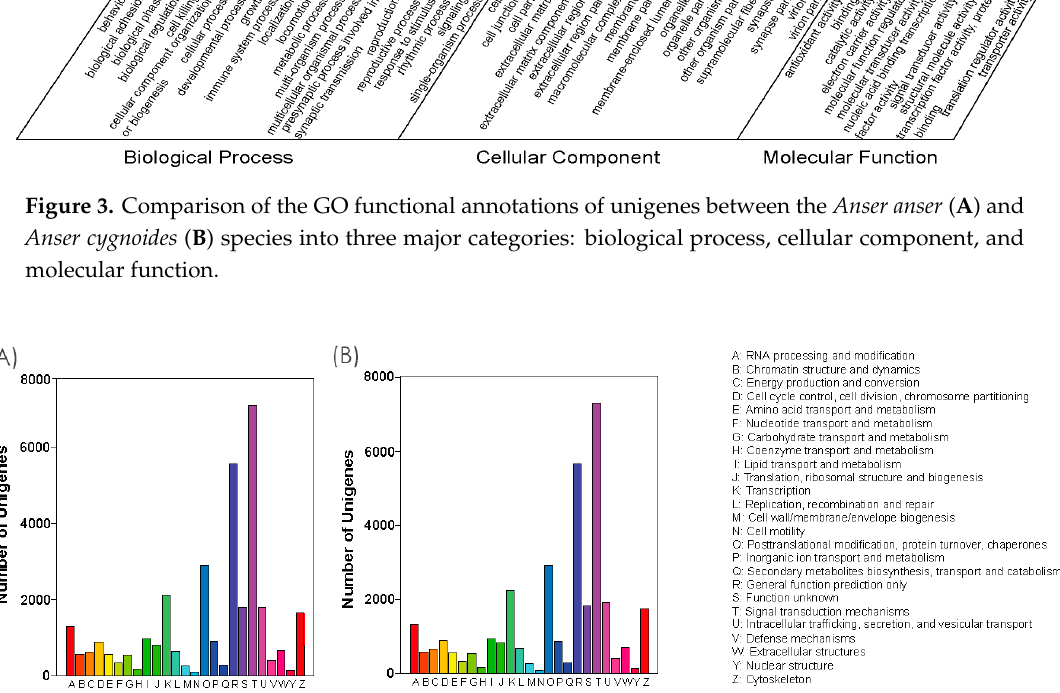
Figure 4. Transcriptomes of Eukaryotic Orthologous Groups (KOG) classifications for Anser anser ( A ) and Anser cygnoides ( B ). To identify and classify possible functions, all unigenes were aligned to the KOG database.